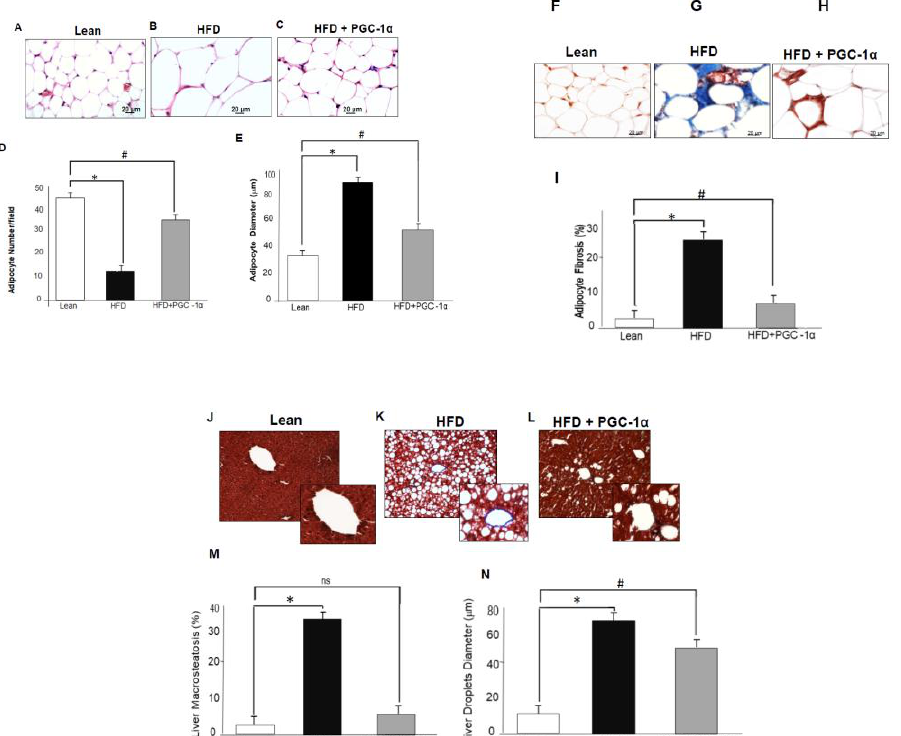
Figure 2. Effects of adipocyte-specific overexpression of PGC-1 α in high-fat-diet (HFD)-fed mice compared to lean and untreated HFD mice. Histological analysis of adipose tissue using Hematoxylin– Eosin of ( A ) lean, ( B ) HFD, and ( C ) HFD+ PGC-1 α mice; ( D ) Adipocyte number and ( E ) adipocyte diameter. Masson trichrome staining photomicrographs of PGC-1 α expression at the adipose tissue level of ( F ) lean, ( G ) HFD, and ( H ) HFD + PGC-1 α mice; ( I ) Percentage of adipocyte fibrosis, ( J – M ) liver macrosteatosis, and ( N ) liver lipid droplet diameter. Bar 20 µ m. Data are expressed as mean ± S.E.M. ( n = 5); * p < 0.05 versus lean; # p < 0.05 vs. HFD